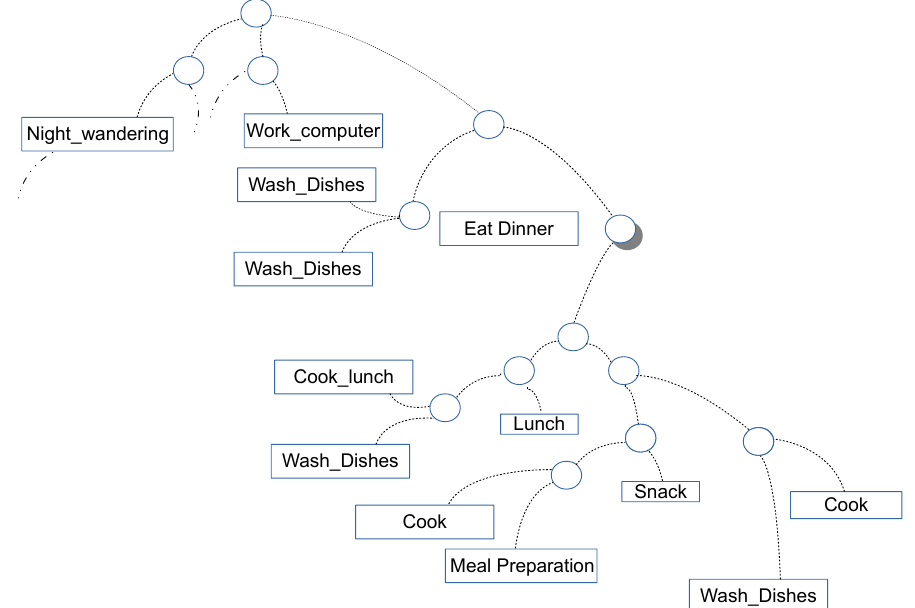
Figure 3. Cluster hierarchical model portion example obtained by exploiting SVMs. Picture inspired by